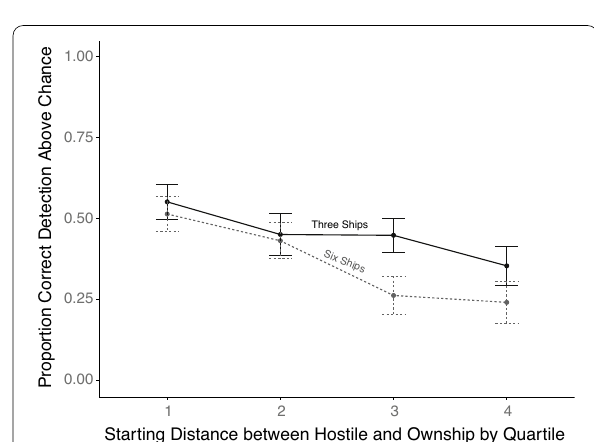
Fig. 5 Detection accuracy for each set size as a function of the starting distance between the usership and hostile ship. Error bars represent one standard error